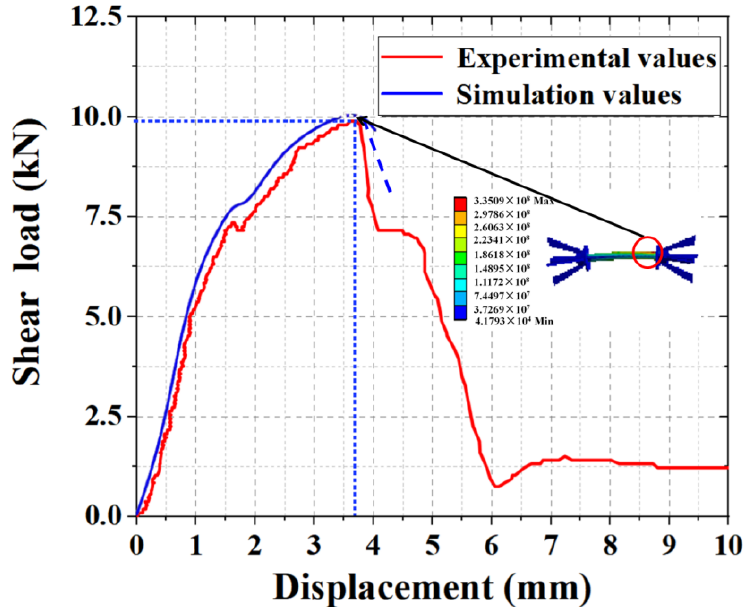
Figure 14. Shear experiment and simulated load–displacement comparison curve.